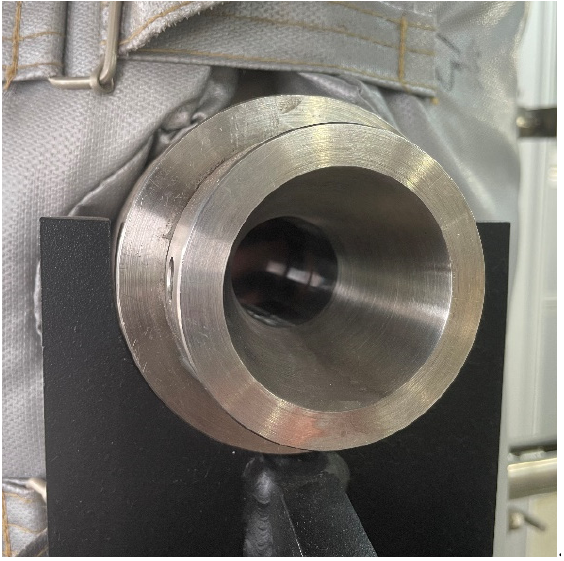
Figure 5. Physical diagram of the external observation window for the seawater simulation chamber.